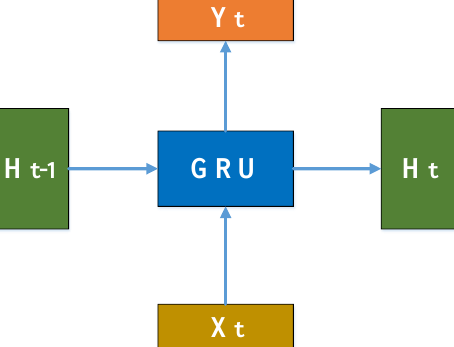
Figure 3. Gate recurrent unit (GRU) input and output structur e.